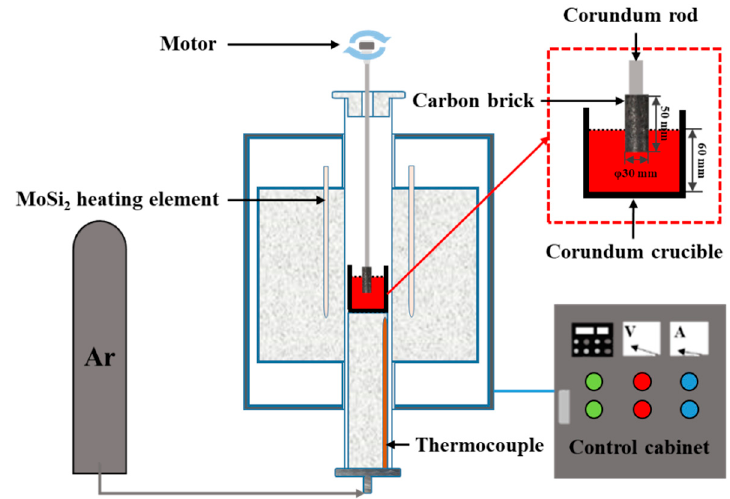
Figure 2. Schematic diagram of the experimental apparatus.